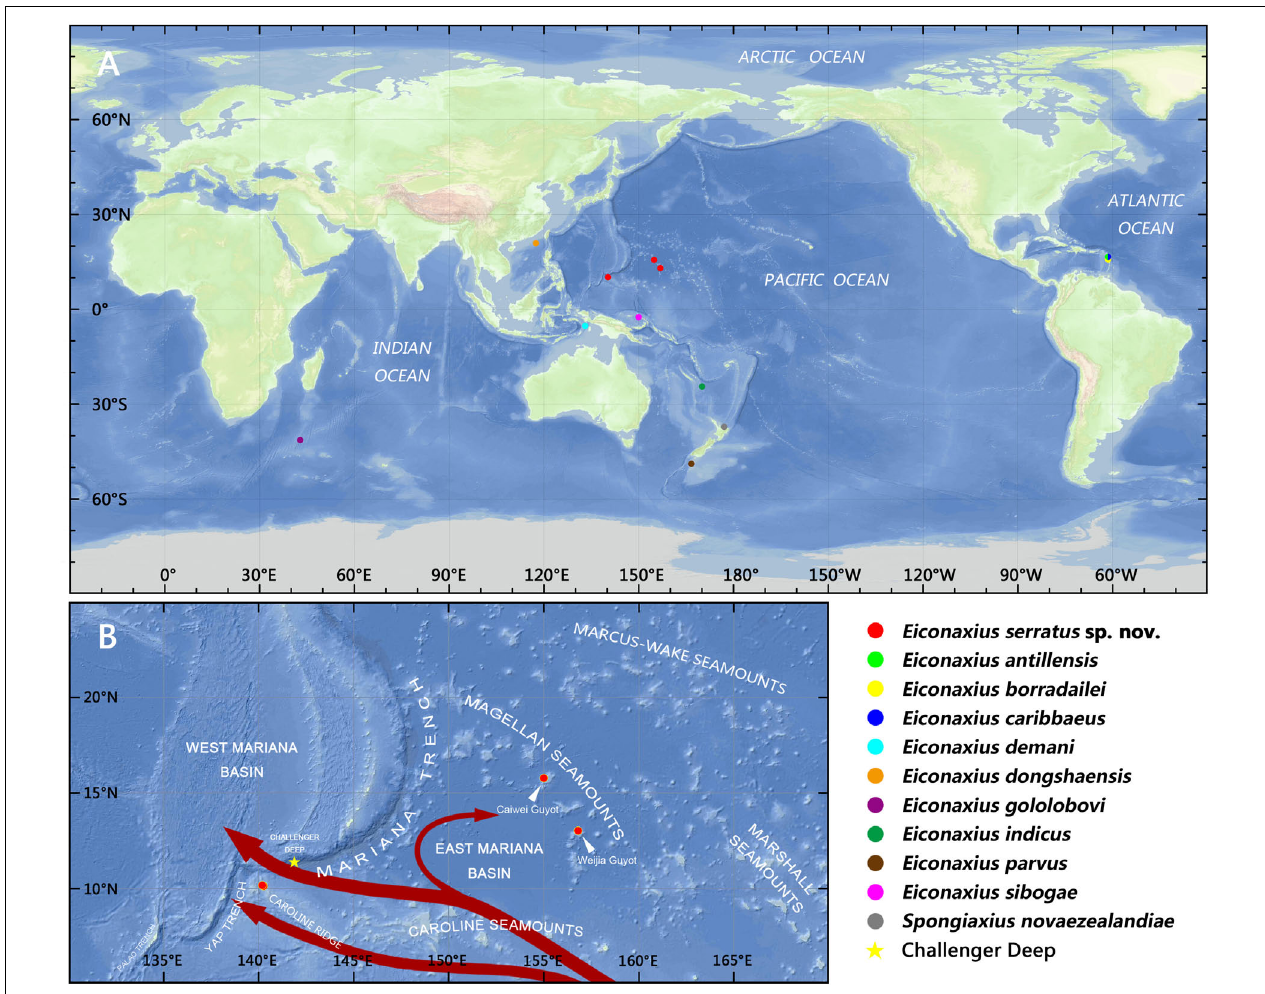
FIGURE 11 | (A) Collection locations of the axiid specimens in the present study; (B) collection locations of Eiconaxius serratus sp. nov. , with schematic diagram of the deep water currents at low latitudes in the West Pacific in the upper deep layer (marked in red arrows, from Kawabe et al., 2003; Kawabe and Fujio,